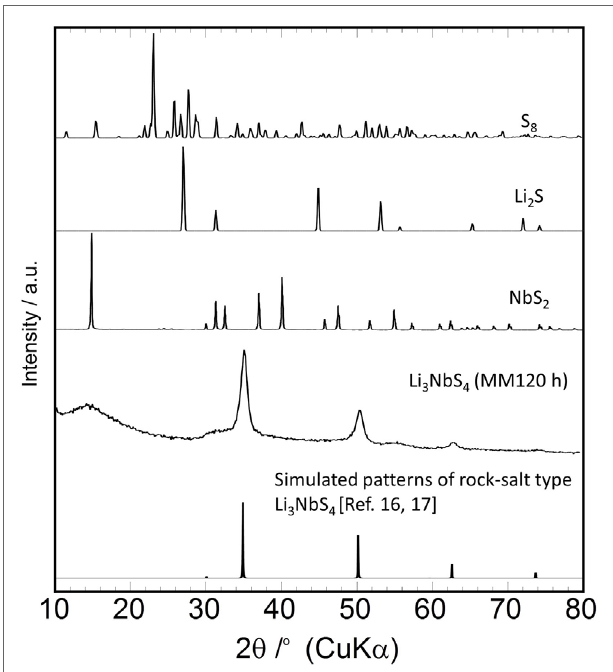
FigUre 1 | XrD patterns of samples of li 3 nbs 4 prepared by MM for 120 h . The XRD patterns of the starting materials and rock-salt Li 3 NbS 4 are also